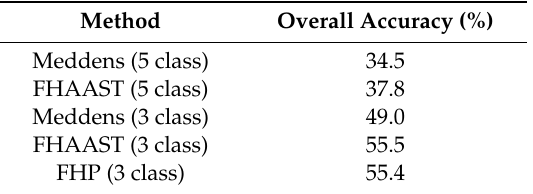
Table 5. Overall accuracies (%) for each method converting 2014–2018 insect and disease survey (IDS) severity estimates from legacy trees-per-acre measurements to percent mortality.